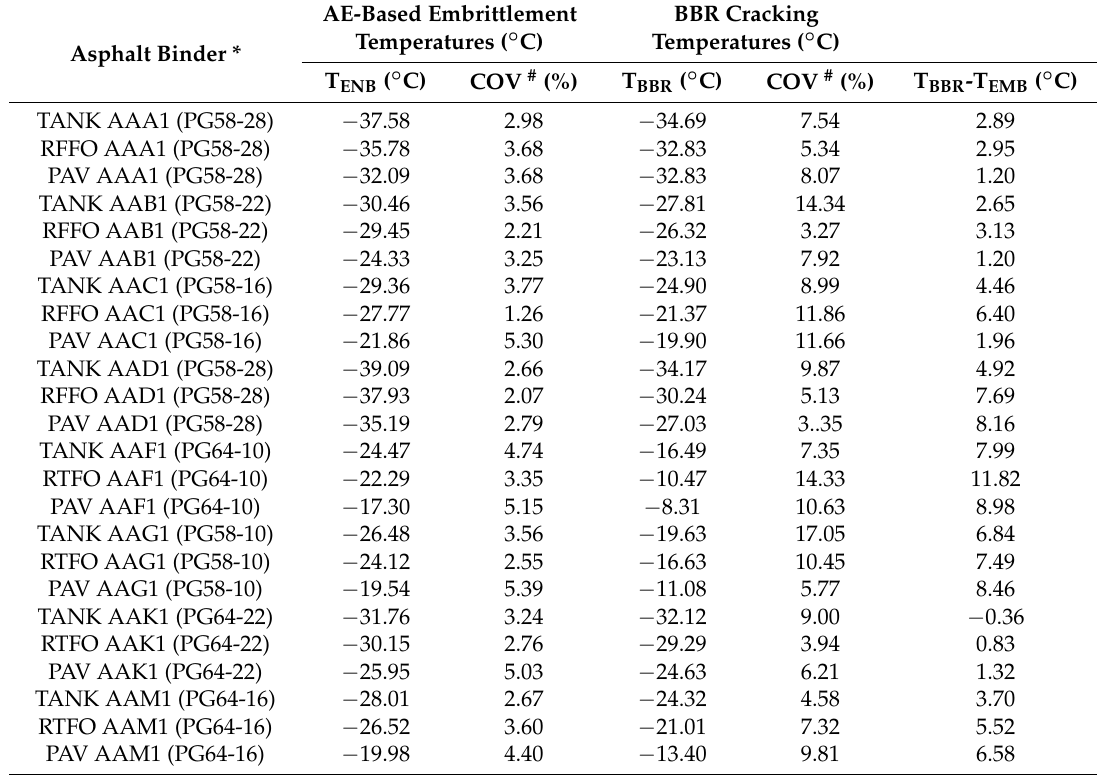
Table 1. AE-based embrittlement temperature and BBR cracking temperatures of several different binders, each with three aging